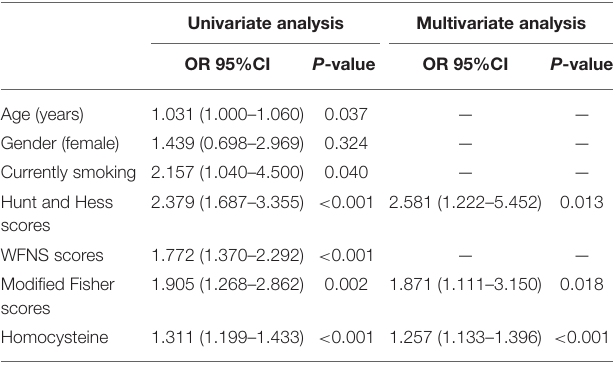
TABLE 2 | Separate logistic regression models for serum homocysteine levels and delayed cerebral ischemia in patients with aneurysmal subarachnoid hemorrhage. OR